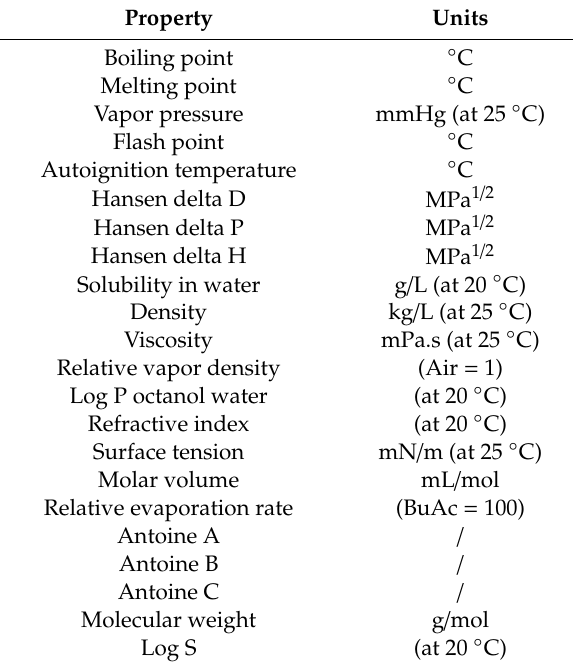
Table 6. Physical properties in the dataset with associated